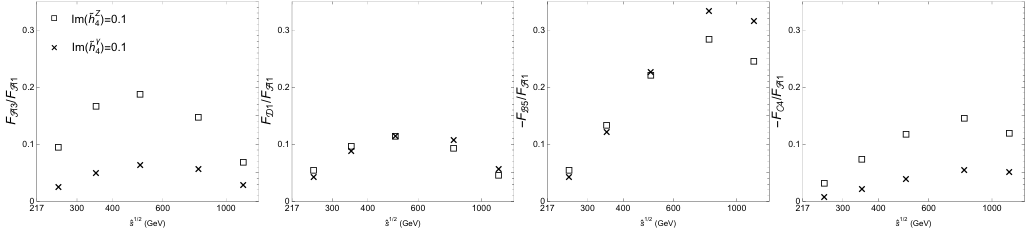
Figure 7 . The angular coe(cid:14)cients F panel) and F (right panel) divided by F C 4 (cid:0) coe(cid:14)cients are doubly constrained to be identically zero by CP invariance and CP e T invariance. In each panel, 2 points give predictions for e h Z